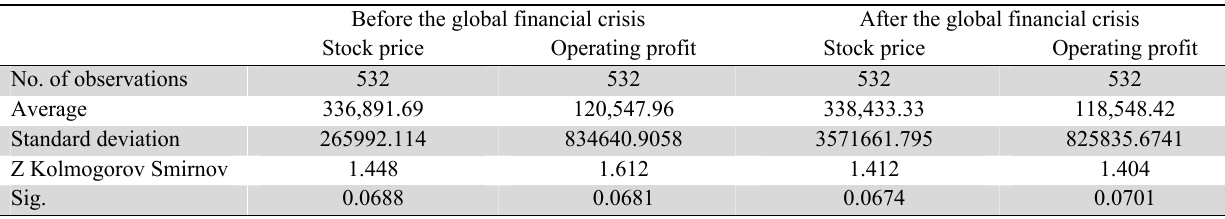
Testing normality with Kolmogorov–Smirnov